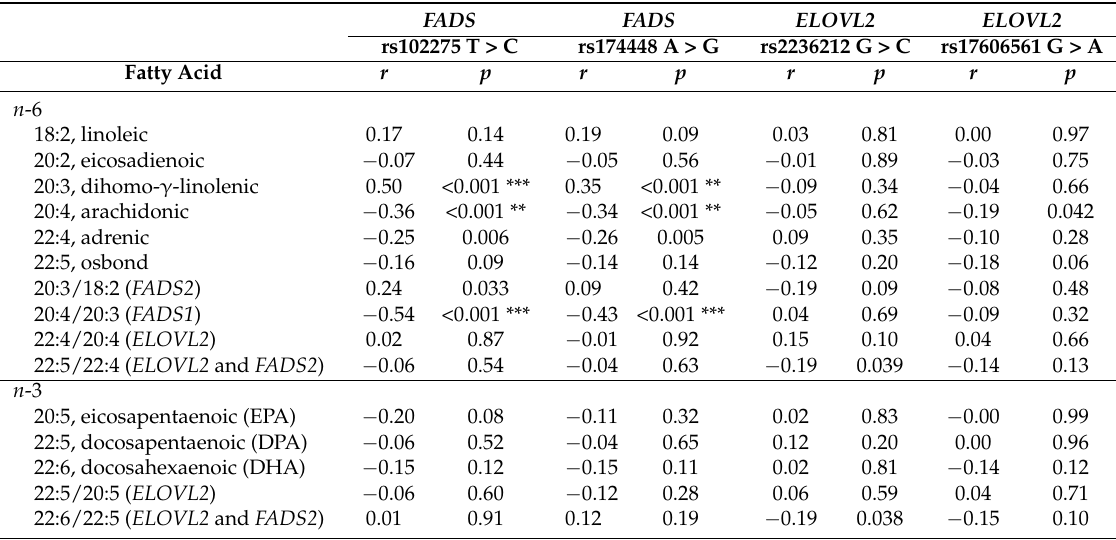
Table 5. Associations between cord serum proportions of n -6 and n -3 PUFAs (% of total FA) and fatty acid desaturase ( FADS ) and elongase ( ELOVL ) polymorphisms. FADS FADS ELOVL2 ELOVL2 rs102275 T > C rs174448 A > G rs2236212 G > C